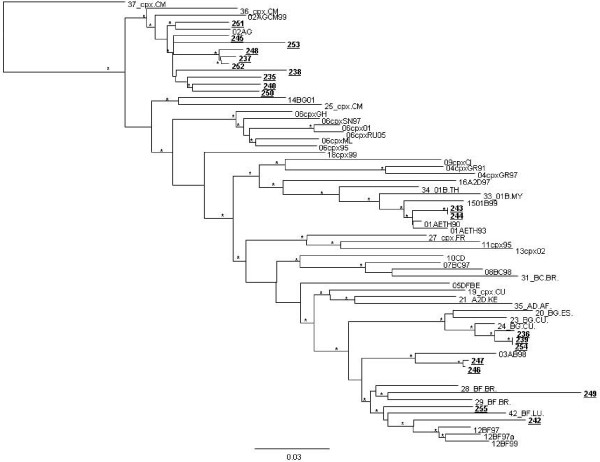
Phylogenetic relationships on pol gene (1302 nt) of the HIV-1 pol gene between the HIV-1 putative recombinant forms circulating in Italy (shown in bold and underlined) and the reference sequences of the CRFs of the HIV-1 M group from the Los Alamos HIV Sequence Database. Bootstrap values <90% are not shown. The scale bar indicates 3% nucleotide sequence divergence.* indicates the P value < 0.001 (zero length branch test) and the bootstrap values more than 70%.